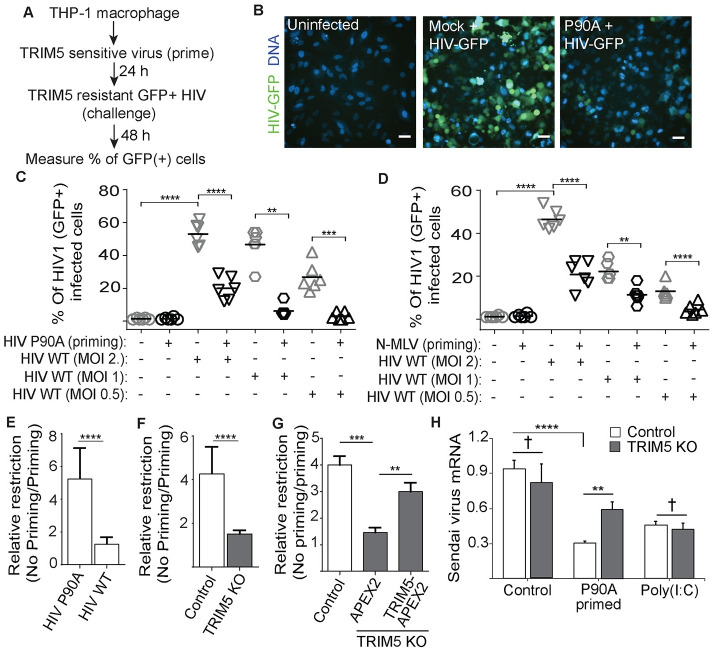
Stimulation of TRIM5 signaling induces an antiviral state.(A) Schematic overview of experimental model for sequential viral “priming and challenge” experiments. PMA-differentiated THP-1 macrophages were cultured in the presence of the “priming” virus for 24 hours prior to subsequent “challenge” with GFP-expressing WT HIV-1 for next 48h. The percentage of cells showing GFP-positivity was determined by high content imaging. (B,C) THP-1 cells were primed with HIV-1 CA P90A (CrFK MOI = 3) prior to challenge with different CrFK MOI of WT HIV-1. Representative images (B) of mock infected, infected, or primed and infected cells captured by high content imager. Scale bar, 50 μm. Plot (C) shows the percentage of cells that become GFP-positive following infection with the challenge virus. (D) THP-1 cells were primed with VSV-G pseudotyped N-MLV (CrFK MOI = 0.5) and then challenged with WT HIV-1 at the indicated MOI. For C and D, each data point represents one well of a 96-well plate with >2000 cells analyzed per well. Data shown is from one representative experiment of 3. See also S4A and S4B Fig. (E) Differentiated THP-1 cells were primed or not with HIV-1 CA WT (TRIM5 resistant) or P90A (TRIM5 sensitive) and then challenged with HIV-1 GFP. The data are expressed as the ratio of infected cells before priming to relative to what is seen in unprimed cells (relative restriction). (F) The effect of TRIM5 knockout on the ability of priming with HIV-1 CA P90A to protect THP-1 macrophages from infection with WT HIV-1 GFP. (G) The relative restriction seen in P90A primed WT or TRIM5 KO THP-1 macrophages stably expressing APEX2 or TRIM5-APEX2 (TRIM5 add-back). For panels E-G, priming virus was used at a CrFK MOI of 3 and HIV-GFP infections were performed at a CrFK MOI of 1. (H) Q-RT PCR analysis of the impact of P90A (CrFK MOI = 3) or poly(I:C) priming on the permissivity of WT or TRIM5 KO THP-1 macrophages to Sendai virus infection. **, P < 0.01; ***, P < 0.001, ****, P < 0.0001; †, not significant by t test or ANOVA.